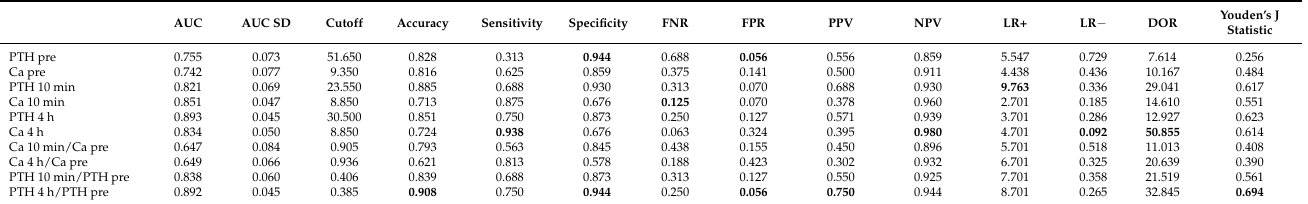
Table 2. Performance of the studied parameters for the identification of patients at risk for postopera- tive